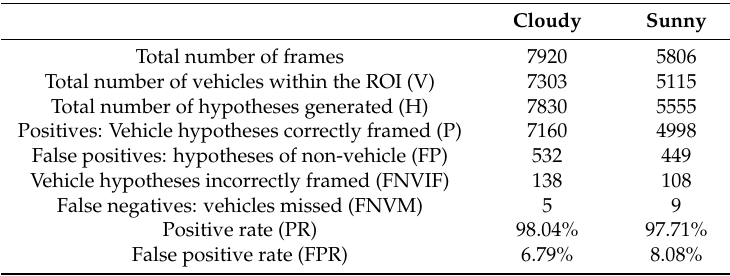
Table 1. Results of Hypotheses Generation.